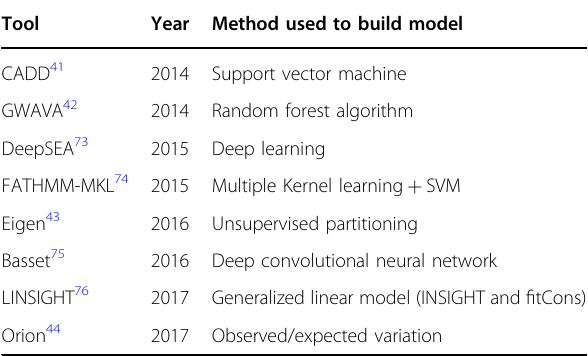
Table 1 Genome-wide tools for estimating impact of noncoding variation